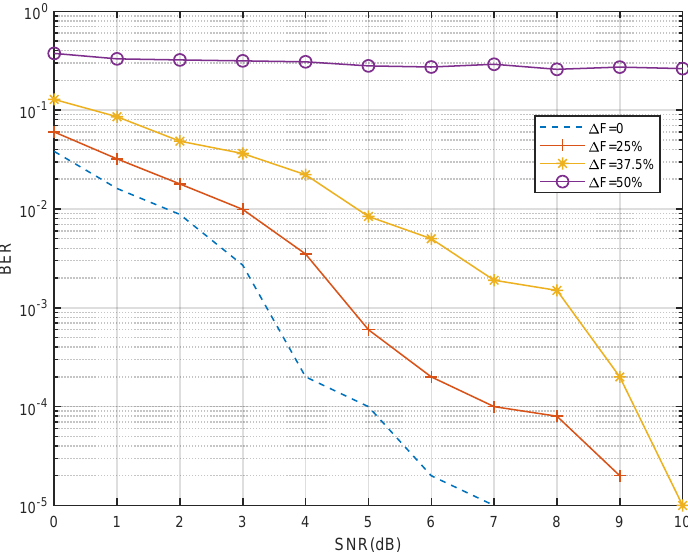
Figure 10. BER of authorized signal with NC-OFDM